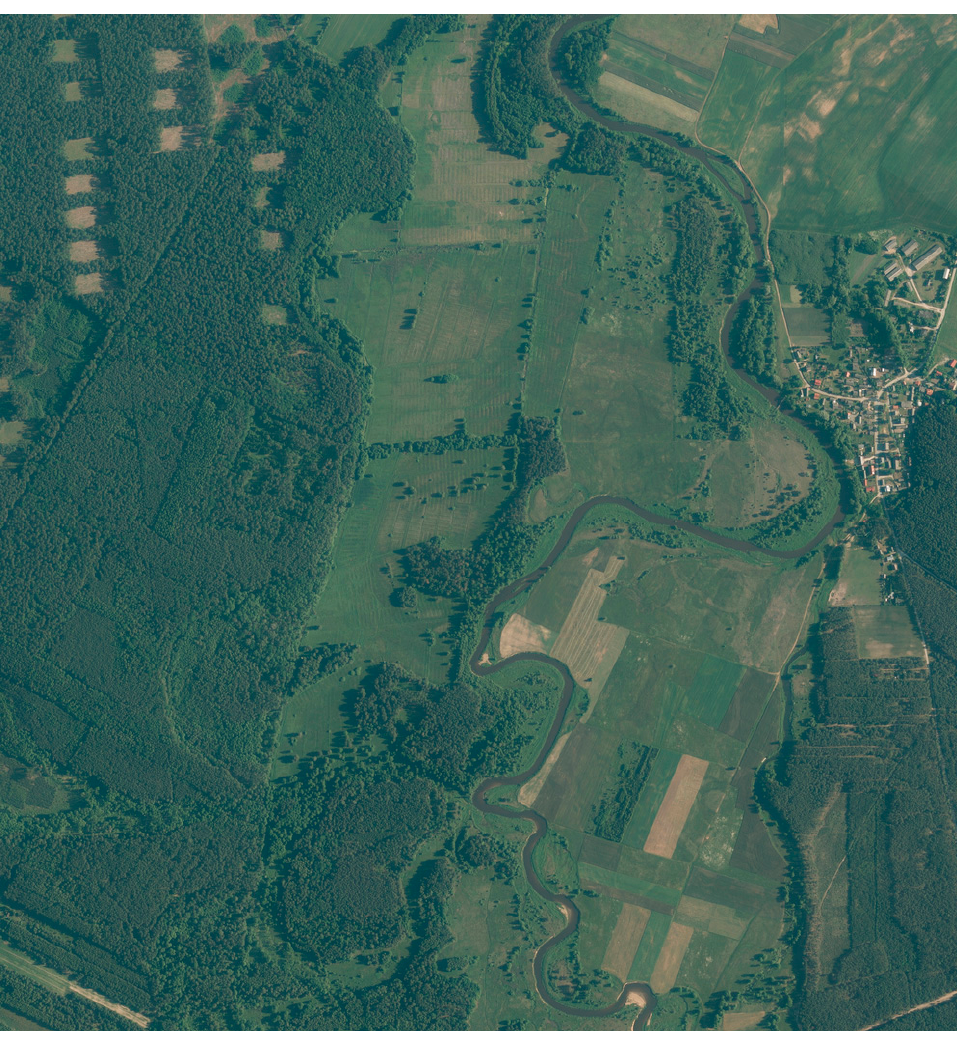
Figure 7. Test area 72961_840430_M-34-40-B-a-2-3 [42]. Simultaneously, ground truth segmentation masks were prepared by manually dividing the test image into a fixed number of regions. For the number of clusters between 2 and 10, there was an average of 17.97% ± 8.7% patch-wise difference between ground truth and the unsupervised approach results. The more clusters were predicted the difference was larger. Figure 9 represents the best result, which was acquired for six clusters where the unsupervised approach misclassified 6% of patches.